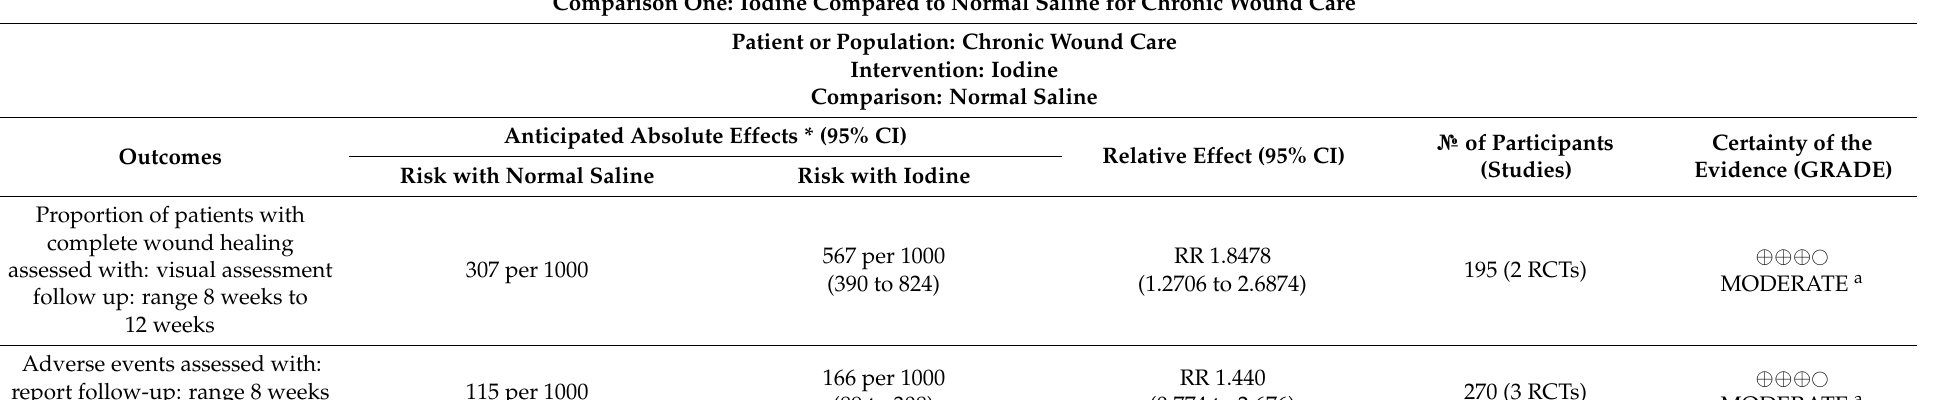
Table 2. Summary of findings table with comparison between iodine and saline solution in chronic wound care. Comparison One: Iodine Compared to Normal Saline for Chronic Wound